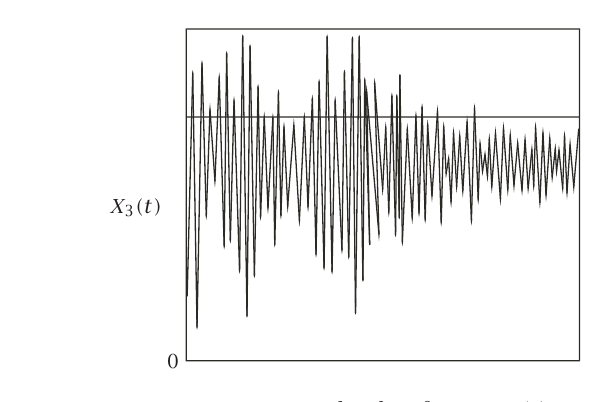
Figure 5.5 The plot of series X